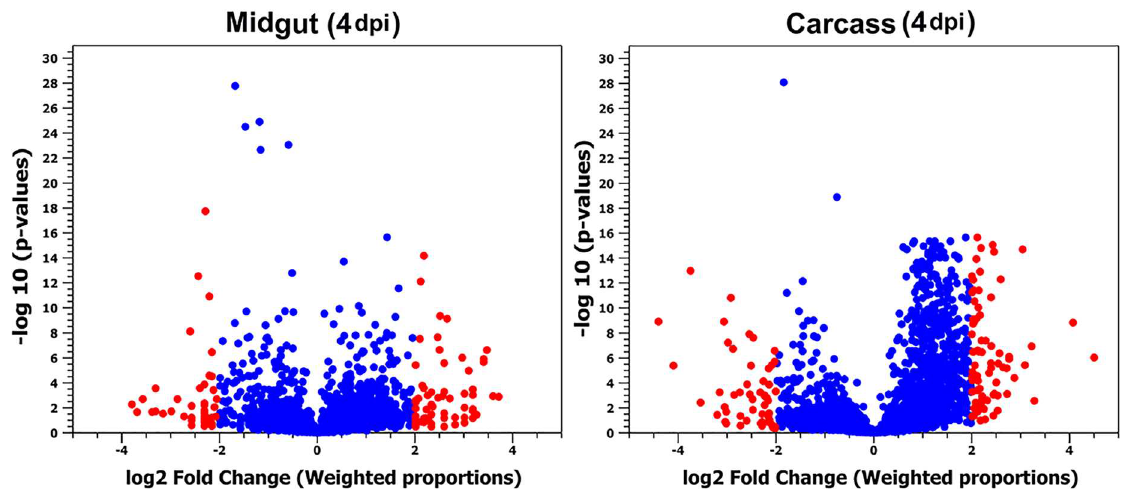
Fig 4. Volcano plot of differentially expressed Ae . aegypti lincRNAs in DENV-2 infected samples (midgut and carcass) compared with their corresponding controls. Dots with red color represent lincRNAs with more than 4-fold changes due to DENV-2 infection.